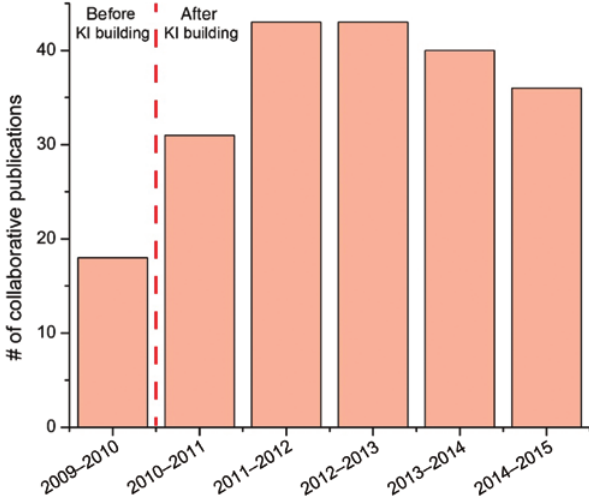
Figure 2: Collaborative impact. The number of collaborative publi- cations produced by the institute have doubled since investigators began cohabitating in the new KI building. Data provided courtesy of the Koch